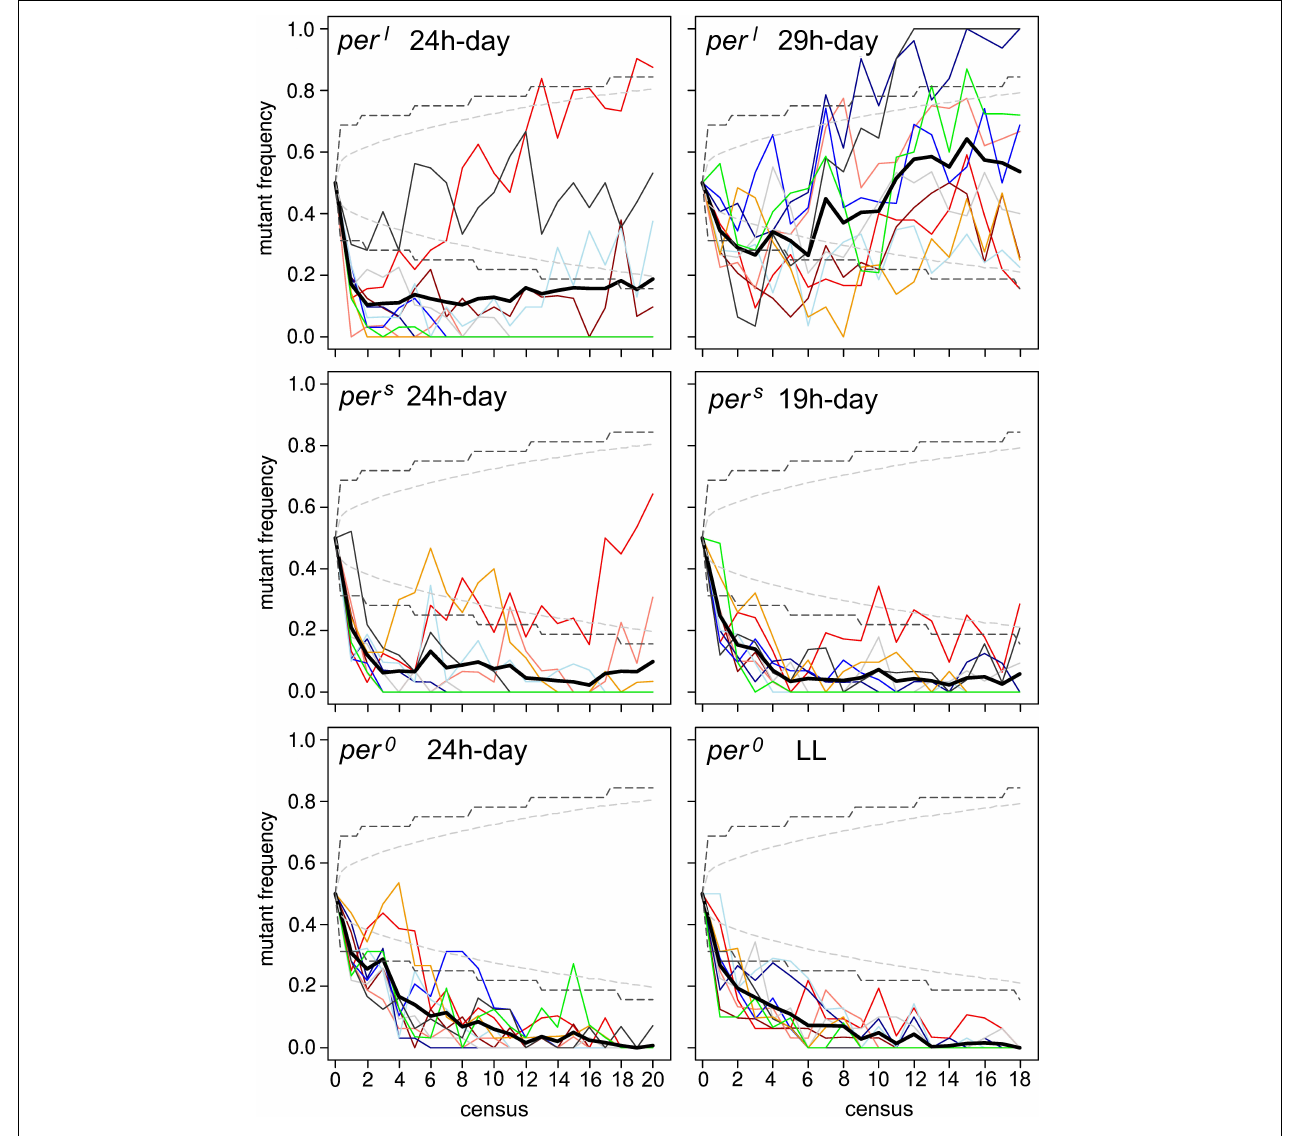
FIGURE 7 | Results of the competition assay experiment in 24-h, 29-h and 19-h days (for per l and per s mutants, respectively) and 24-h and constant light (LL) for per 0 and WT CS . For each assay 10 food vials with the period mutants competing with wildtype flies were established. The mutant frequency per generation was determined separately in each vial (thin colored lines) and averaged over all vials (thick black line). Hatched gray lines show simulated 95% confidence limits for the frequency in the whole population in scenarios assuming pure genetic drift (identical fitness of wild-type and mutant) and hatched black lines the corresponding 95% confidence limits for samples of 32 males as taken in the experiments (see text for more details on the creation of these intervals; for details see section “Materials and Methods”). Except for the assay in which per l mutants competed with wildtype flies under the 29 h-day (top right), on average the wildtype flies dominated the period mutant flies in all experiments. Nevertheless, in some vials the per l and per s mutants performed better than the wildtype flies even in the 24 h-day, so that the mutants persisted in the overall